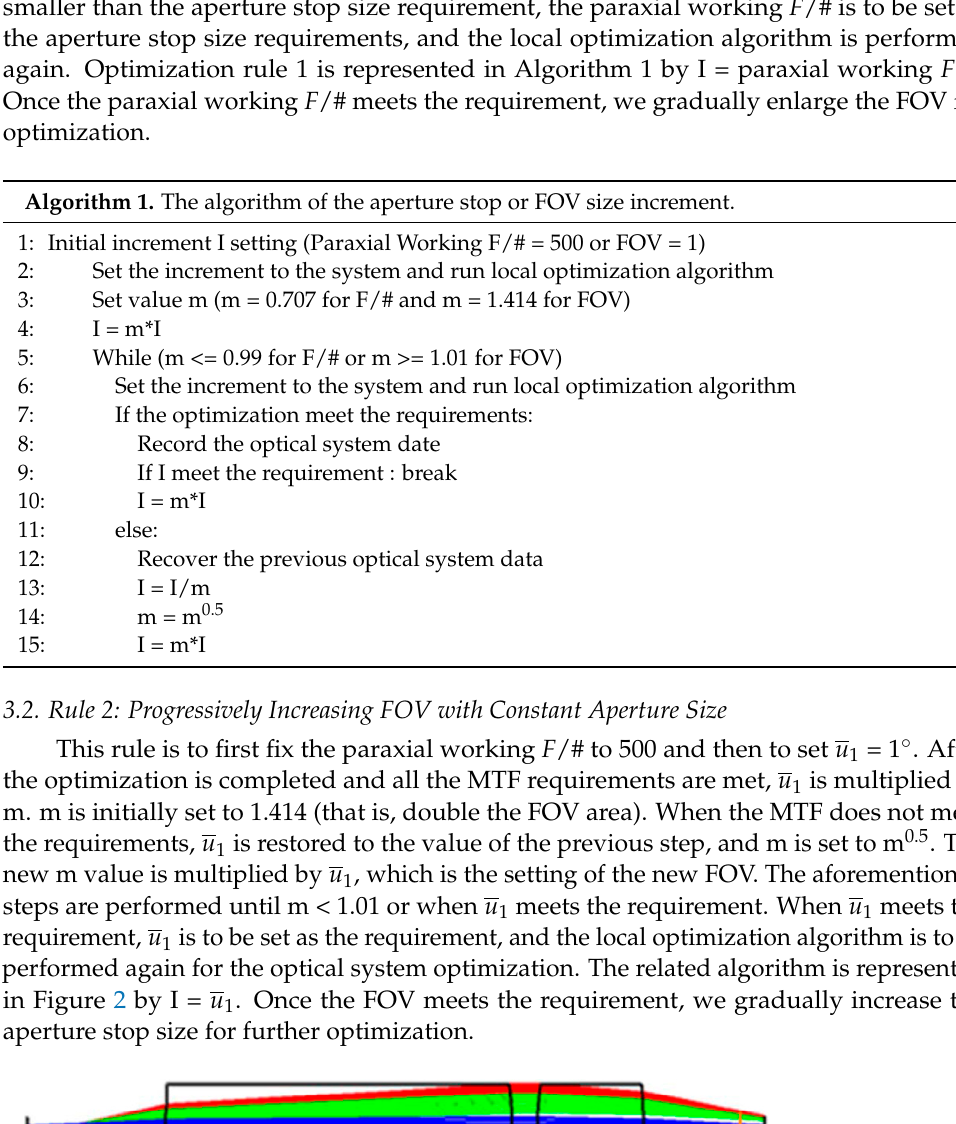
<5 Figure 3. The optimization results with the optical parameters ( l 1 , l 2 ′ , 𝑙̅ (cid:2869) , 𝑙̅′ (cid:2870) , and M) = ( − 2.704 mm, 1.9055 mm, − 1.643 mm, 105.436 mm, and − 3.463) based on rule 2. 4. Lens Design Method Prediction by Deep Learning